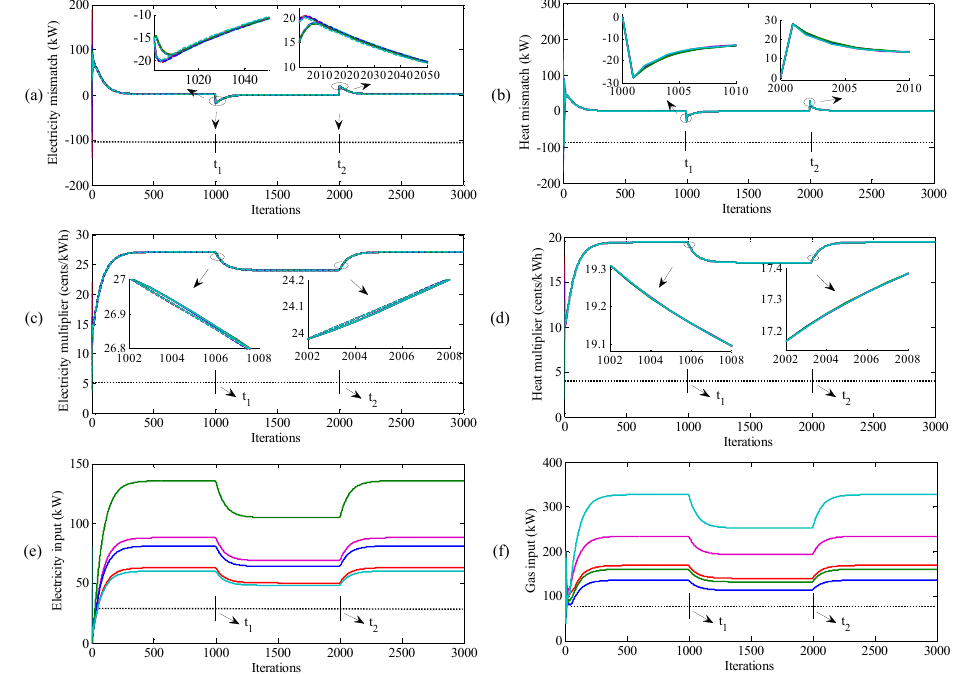
Figure 5. Time-varying demand: ( a ) the electricity mismatch; ( b ) the heat mismatch; ( c ) the electricity multiplier; ( d ) the heat multiplier; ( e ) electricity input; ( f ) gas input.